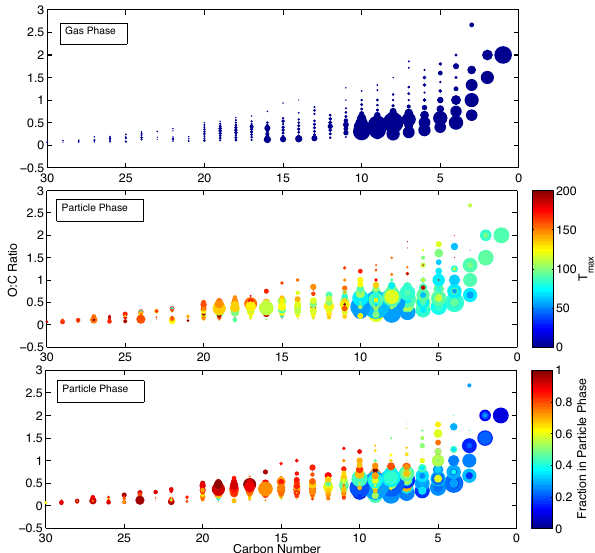
Fig. 9. The oxygen to carbon ratio (O/C) plotted versus carbon number for ions detected in the gas and particle phases when sam- pling from the UW Chamber under α -pinene ozonolysis conditions. In each panel the points are sized by the square root of the mass con- centration. Top: compositions for a suite of compounds measured in the gas-phase. Maximum mass concentrations are measured at compounds with less than 10 carbons. Middle: composition mea- sured during thermal desorptions of collected particles, colored by the temperature at which the desorption signal reaches a maximum. Compounds with increasing carbon number and oxygen content generally require higher temperature to desorb. However, thermal decomposition is evident at low carbon numbers where compounds desorb at relatively higher temperatures. Bottom: as in the middle panel, except colored by the fraction of mass measured in the parti- cle phase. Generally, increasing carbon number and oxygen content in a detected compound is associated with a greater partitioning to the particle